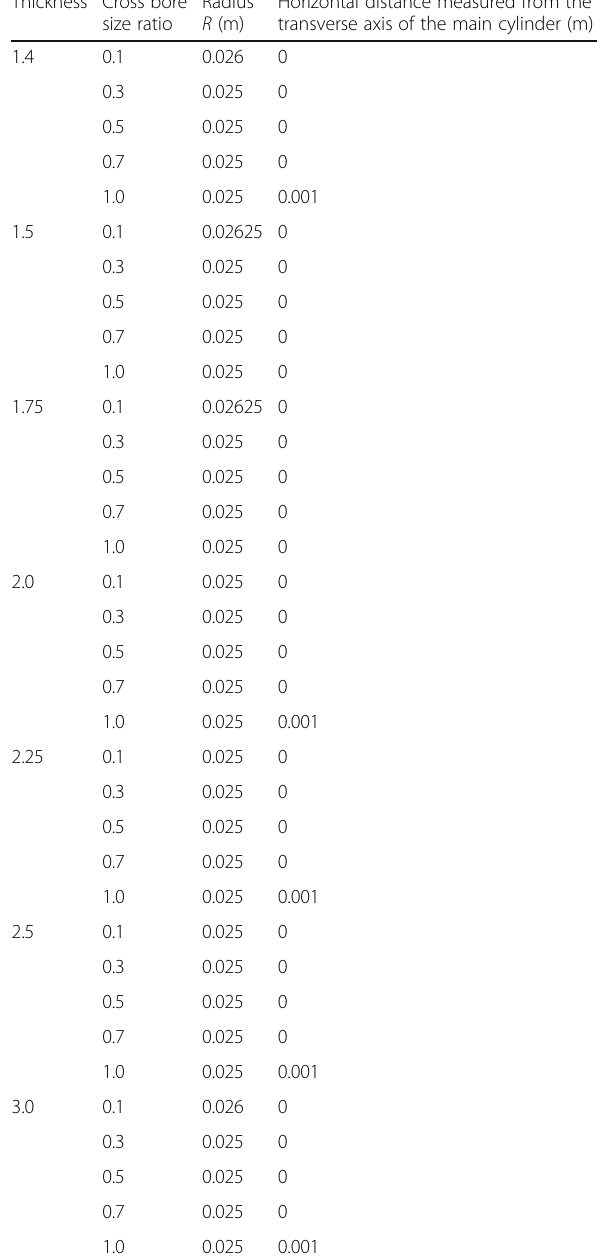
Table 4 Location of maximum hoop stress in the cylinder Thickness Cross bore Horizontal distance measured from the size ratio transverse axis of the main cylinder